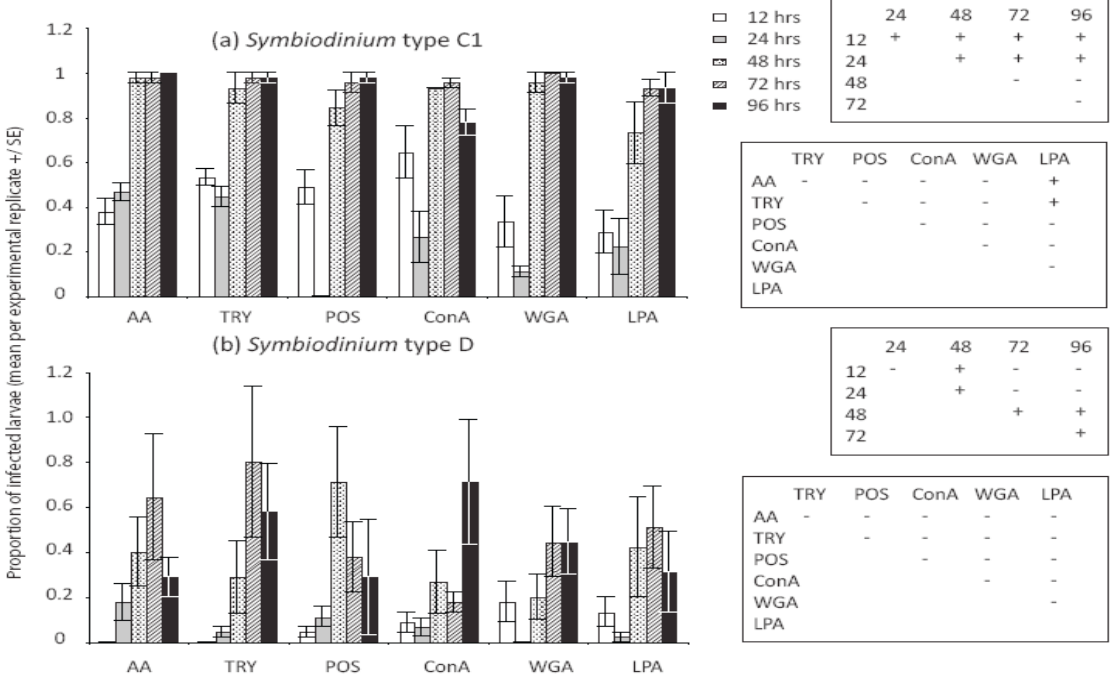
Figure 4. Proportions of infected larvae using ( a ) C1 and ( b ) D Symbiodinium cells (n = 3). Statistical significance of pairwise post-hoc comparisons among sampling times and cell surface treatments are presented in boxes (+ indicates significance at α = 0.05).